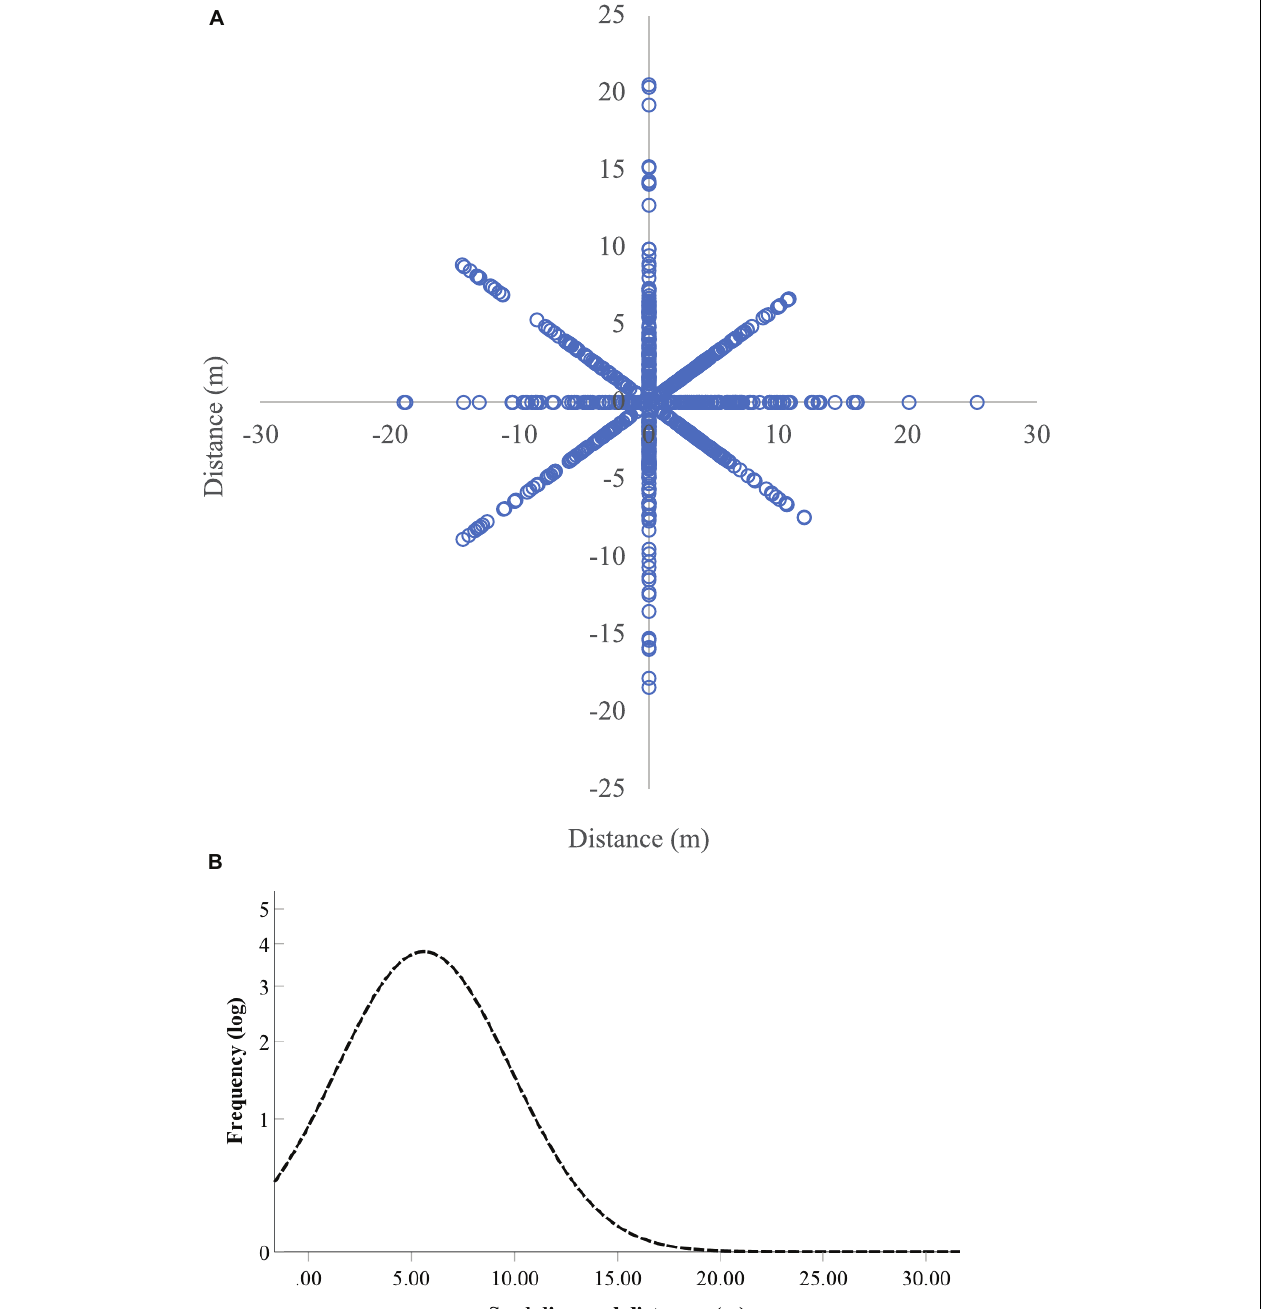
also affects seed consumption and predation by seed-eating animals (Alverson and Díaz, 1989; Winn, 1989; Den Ouden et al., 2005; Pons and Pausas, 2007; Yi and Zhang, 2008; Yi et al.,